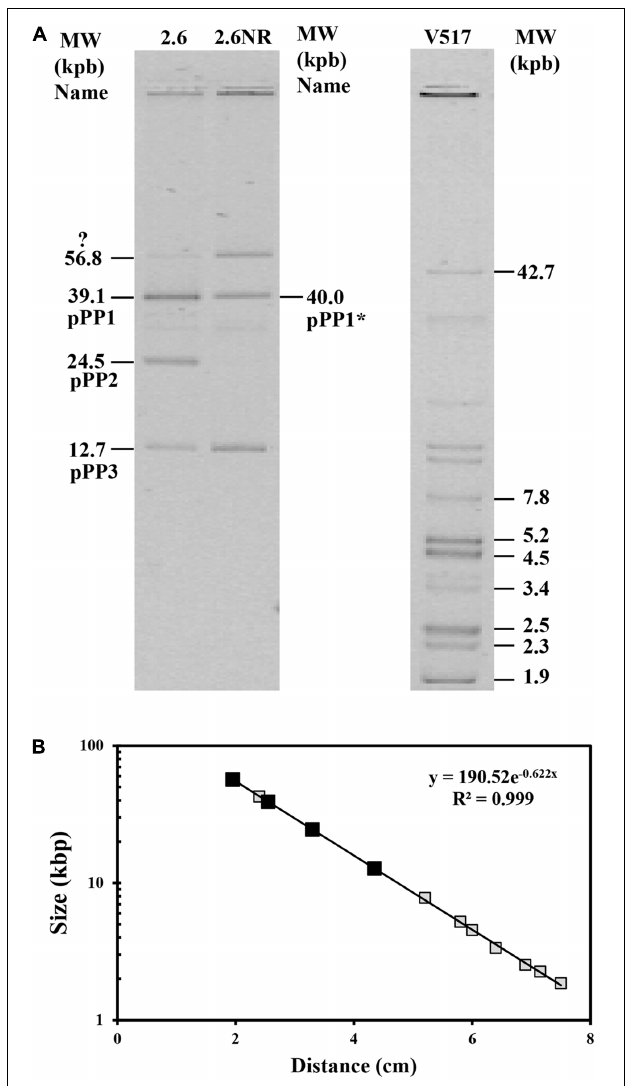
FIGURE 4 | Detection of plasmids of P. parvulus 2.6 and 2.6NR strains. Plasmids preparations of P. parvulus strains and of E. coli V517 were analyzed in a 0.7% agarose gel. (A) The image of the gel. The three samples were run in the same gel. In (B) the calibration curve for plasmid size determination is depicted. Symbols: plasmids from E. coli V517 ( (cid:3) ), plasmids from P. parvulus strains ( (cid:4)